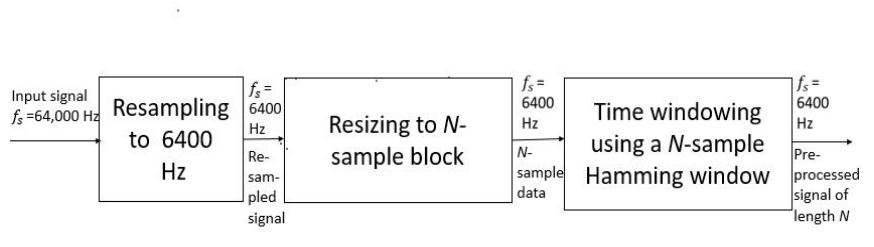
Figure 1. Block diagram of the preprocessing